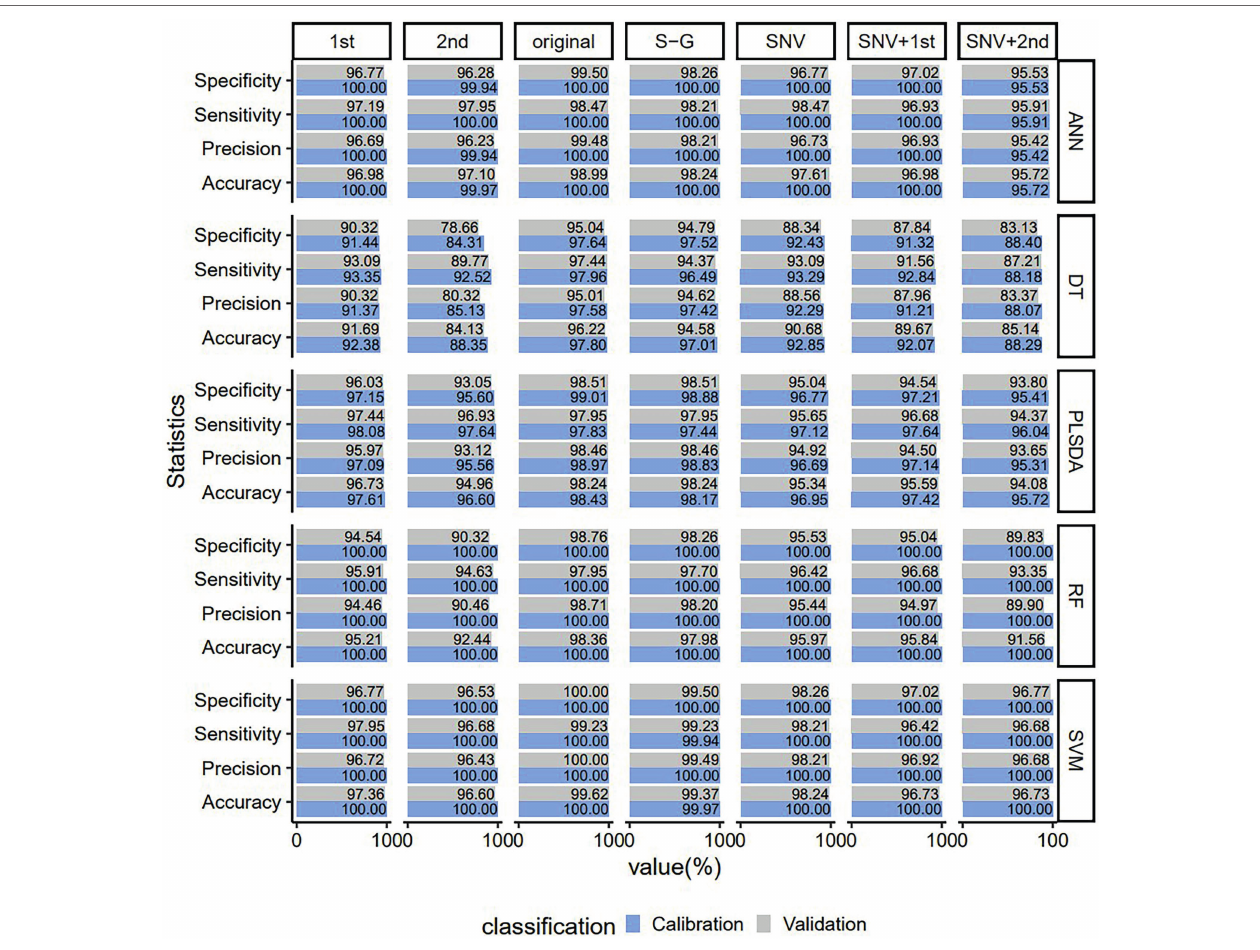
FIGURE 3 | Predicting the performance of PLSDA, SVM, ANN, DT, and RF VIS–NIR classification models for young and old leaves of Toona sinensis based on seven VIS–NIR spectral preprocessing methods. Original, no preprocessing; S–G. Savitzky–Golay; SNV, standard normal variate; 1st Der, first derivative; 2nd Der, second derivative; SNV + 1st Der, Stsandard Normal Variate combined with first derivative; SNV + 2nd Der, Standard Normal Variate combined with second